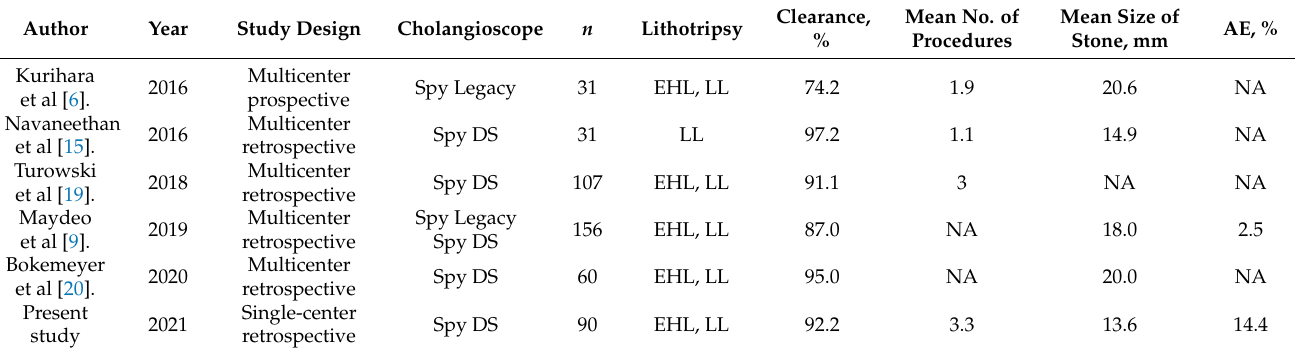
Table 9. Summary of studies on the characteristics and outcomes of stone removal procedures by